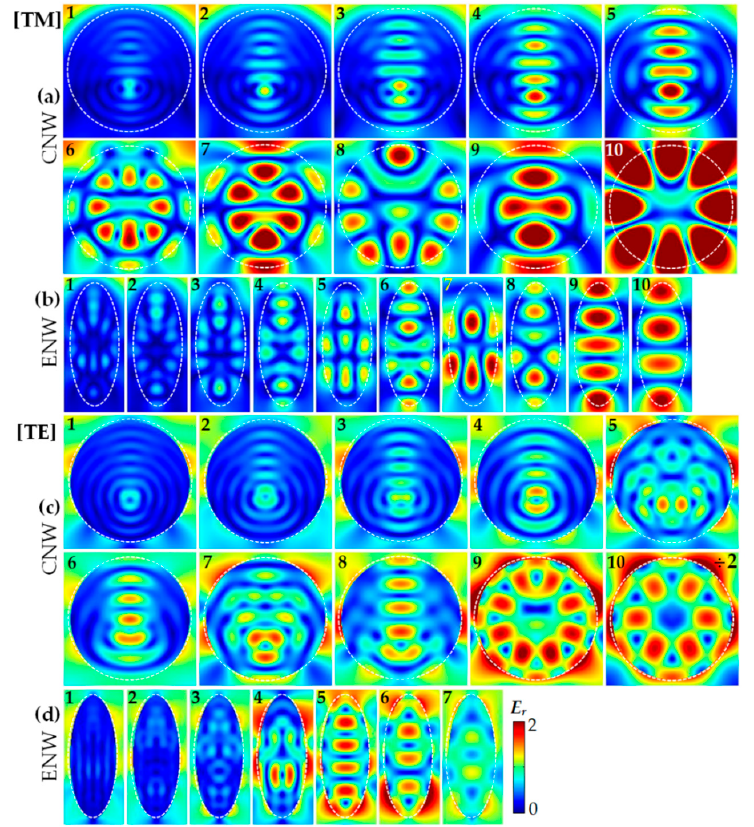
Figure 3. The representative normalized electric field ( E r ) profiles of the CNW and ENW at the absorption peaks indicated by Arabic numerals in Figure 2a,b: ( a , b ) for TM and ( c , d ) for TE light illumination (with an identical color scale); ( a , c ) for the CNW with D = b = 500 nm and ( b , d ) for the ENW with a = 200 and b = 500 nm, respectively. Note that the E r intensity in c (10) is properly shrunk for better illustration.